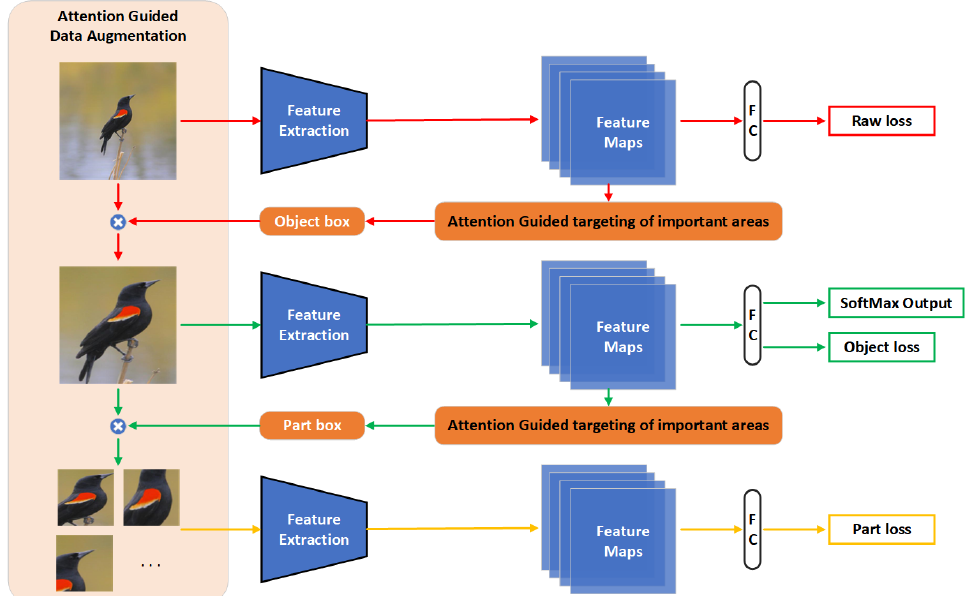
Figure 1. The structure of the fine-grained bird classification model, where all three Feature Extraction and Fully Connection (FC) represent the same one of the model. The Feature Extraction extracts the features of the image, and the FC classifies the features. Object images and key part images are acquired by attention-guided data augmentation during the training process. The model is trained simultaneously using the raw image, the object image, and the key part image to enhance the training effect of the model. The model’s final prediction result is based on the object image prediction